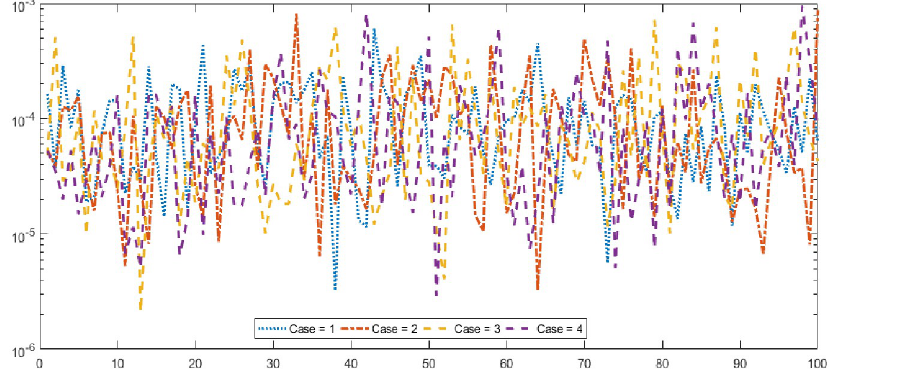
Fig 8. MAD values for each case of problem